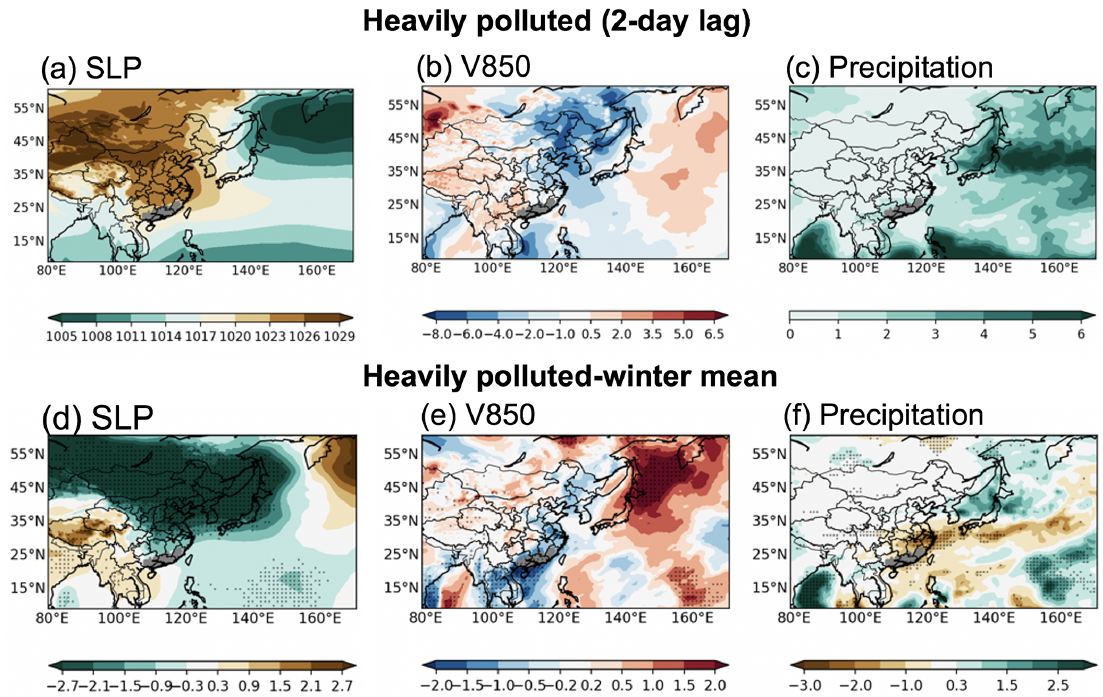
Figure 8. Average (a) SLP (hPa), (b) V850 (ms − 1 ) and (c) precipitation (mmd − 1 ) 2d before heavily polluted days, and the difference (2d before heavily polluted days minus winter mean) for (d) SLP, (e) V850 and (f) precipitation during DJF 2013–2017 over PRD. For V850 (b, e) , blue regions represent northerlies and red regions represent southerlies. Dotted regions in (d–f) mark statistically significant differences at the 95% level (determined through a bootstrap resampling method). Grey shading represents the PRD region.